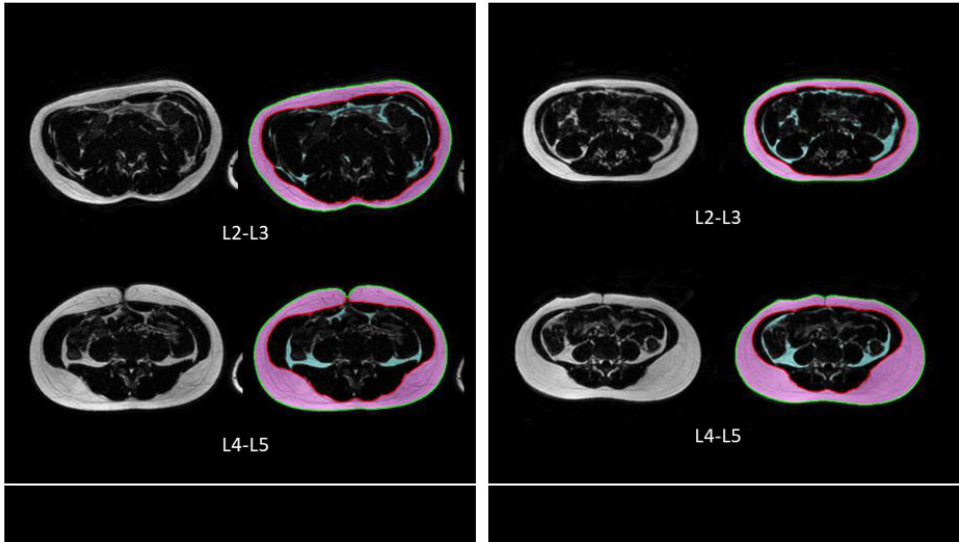
Figure 2. Two example cases showing the qualitative results of the proposed technique detecting the outer abdominal region (converted to green contour) and inner abdominal region (converted to red contour), as well as subcutaneous adipose tissue (magenta pixels) and visceral adipose tissue (cyan pixels).